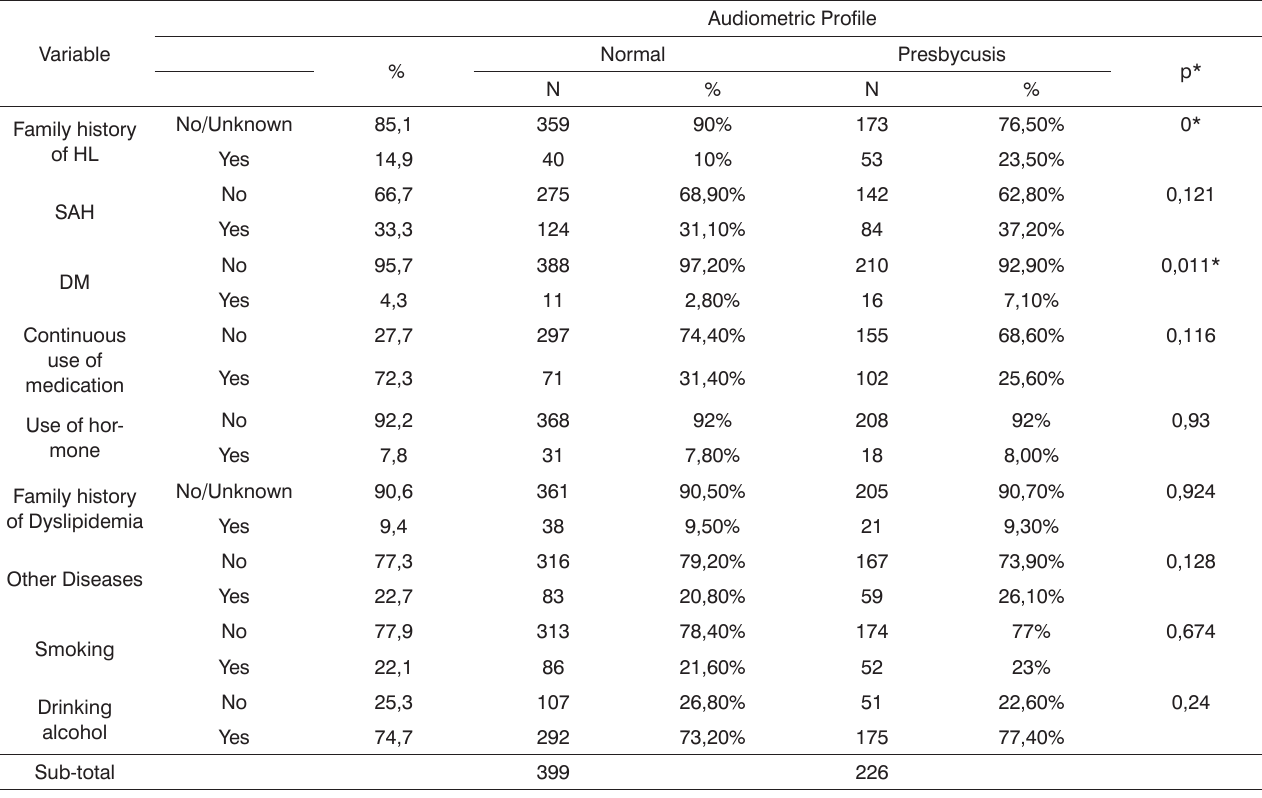
Table 2. Results of clinical data and the audiometric profile.